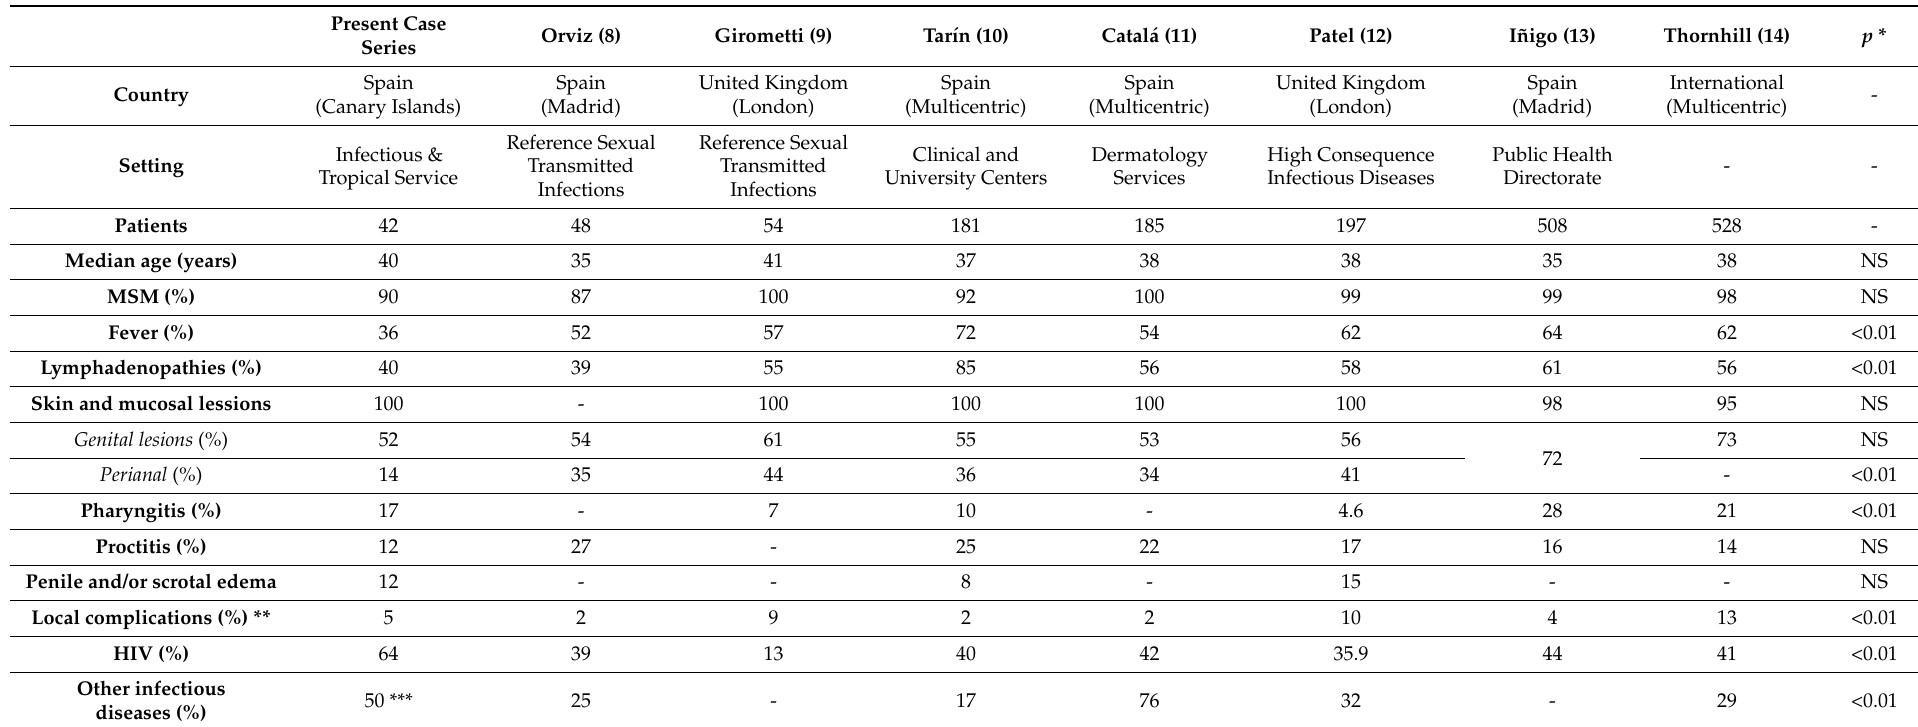
Table 2. Comparison of clinical and epidemiological characteristics of the main series of monkeypox